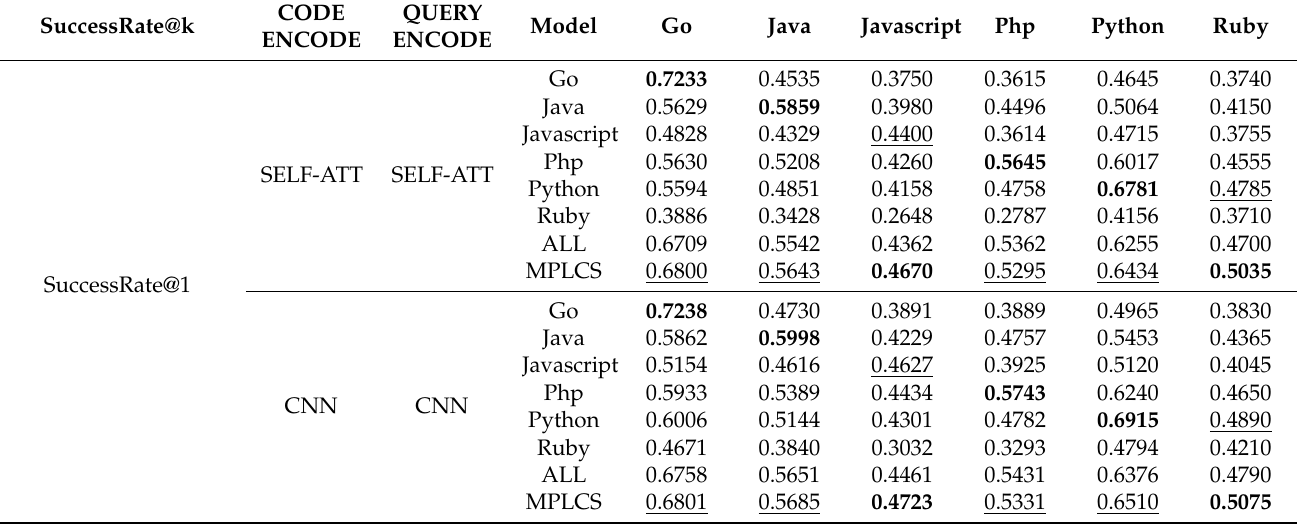
Table 3. SuccessRate@k for each monolingual model and MPLCS model on different language test